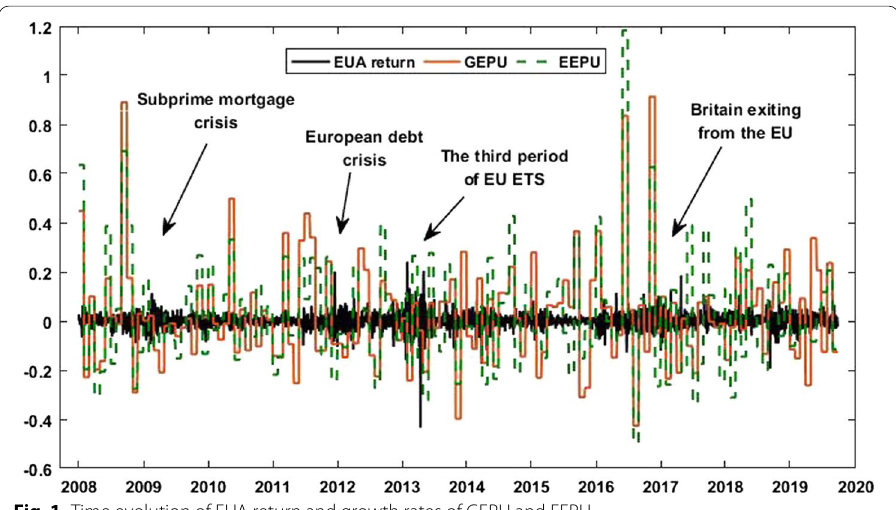
Fig. 1 Time evolution of EUA return and growth rates of GEPU and